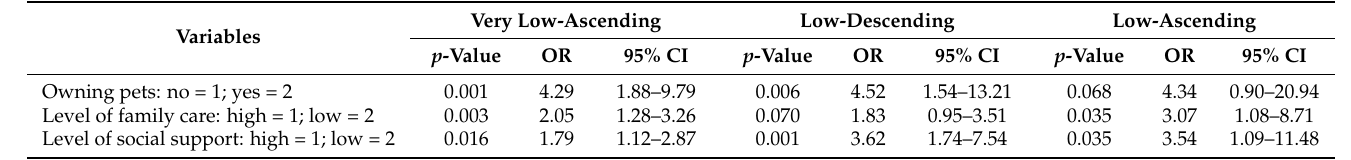
Table 7. Multinomial logistic regression analysis of depression trajectory